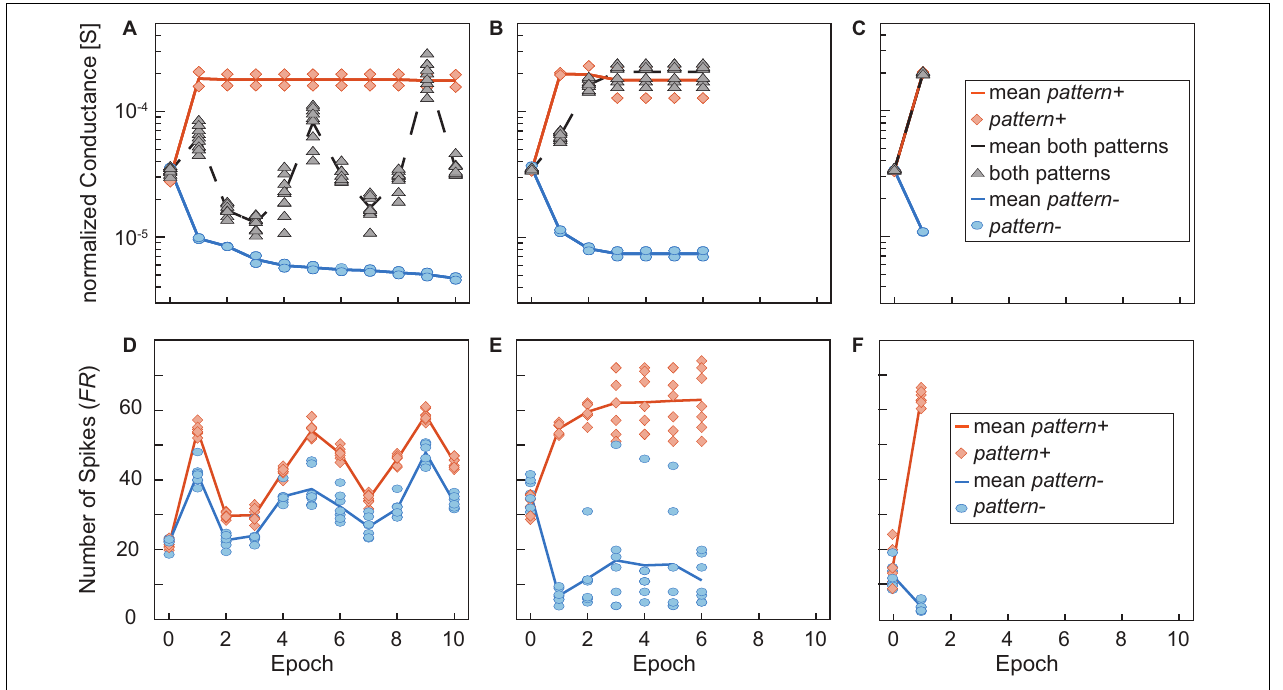
FIGURE 10 | (A–C) Show the conductances normalized to the number of devices per synapse of the synapses receiving pattern+ (orange line and diamonds), pattern- (blue line and circles) and both patterns (black line and triangles) over the training epochs. The overlap was 9 in all cases and the number of devices per synapse was 1 in (A,D) , 8 in (B,E) , and 24 in (C,F) . The solid and dashed lines show the mean values while the different symbols show the values of the actual synapses. (D,E) and (F) show the corresponding numbers of spikes ( FR ) that are generated if pattern+ (orange) or pattern- (blue) is presented to the neuron. The lines again show the mean values while the symbols show the number of spikes generated for the unique